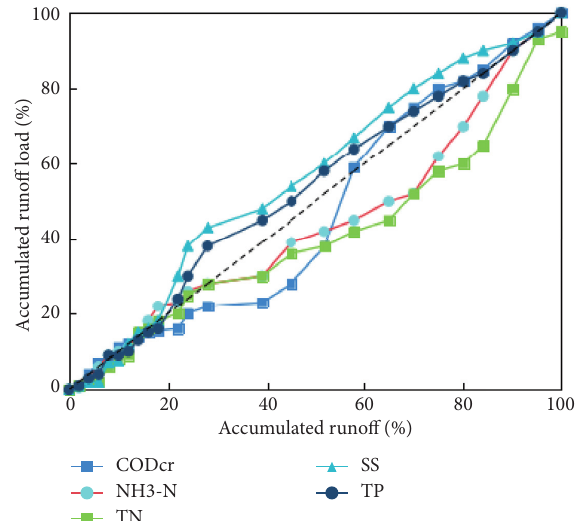
Figure 5: Prediction results of real-time pollution simulation through methods in the literature.